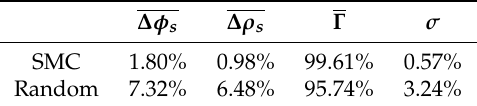
Table 1. Mean relative errors for the mode weight prediction using both Specified Mode Combinations (SMC) and random mode combinations for training the